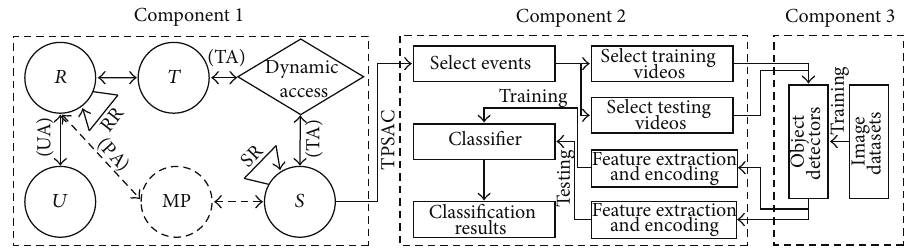
Figure 1: Online multimedia event detection